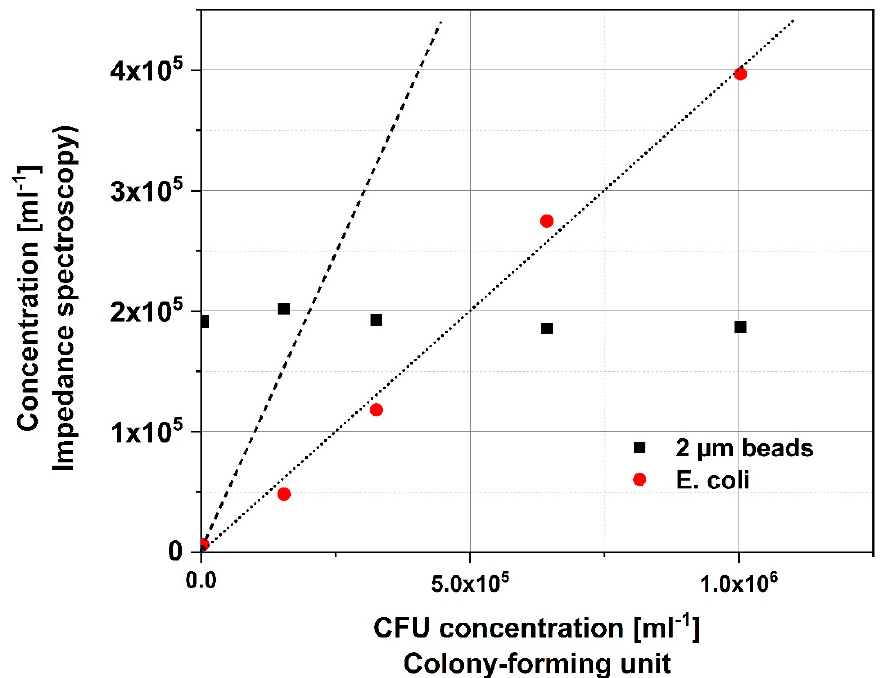
Figure 4. Bacteria concentration measured with the system (impedance spectroscopy) and colony-forming unit counting. The beads were only counted using the system and their concentration was kept constant at 2 × 10 5 mL − 1 . The dashed line represents the 1:1 relation between the two methods. The dotted trend line for the E. coli data has an R 2 value of 0.9937.